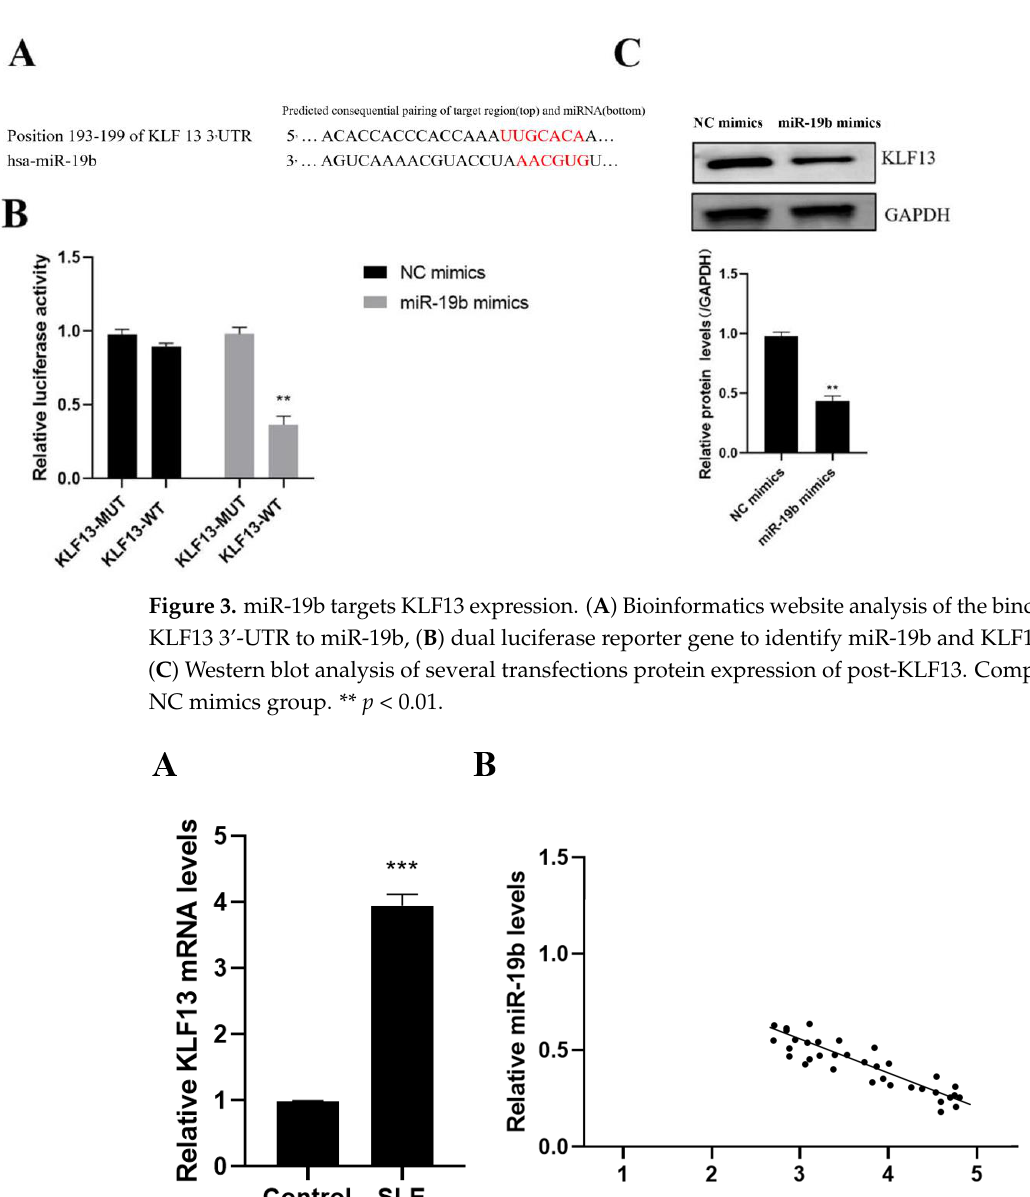
Figure 4. Inverse correlation between KLF13 and miR-19b expression in SLE patients. ( A ) The mRNA expression of KLF13 in SLE patients, ( B ) connection between KLF13 expression level and miR-19b expression level in SLE group, compared with the control group.*** p < 0.001.